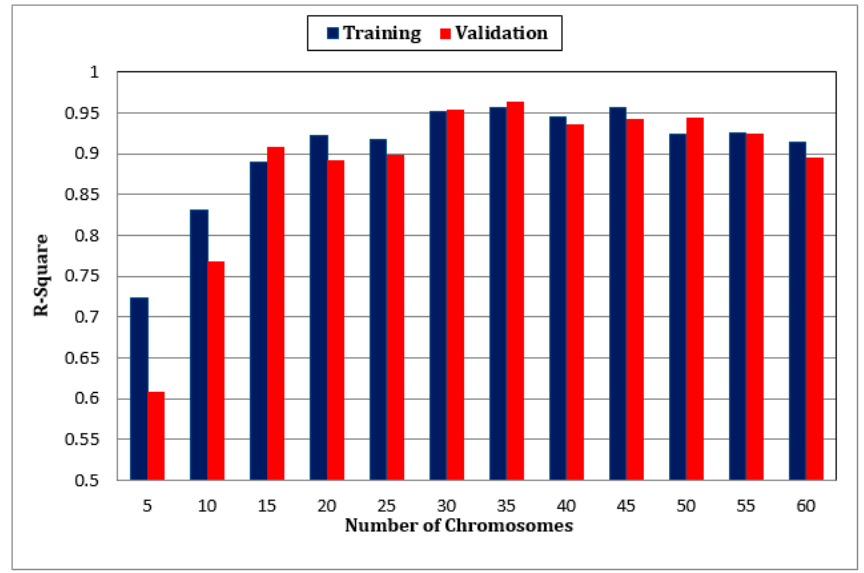
Figure 12. Comparison between coefficient of determination ( R 2 ) of training and validation for different numbers of chromosomes.